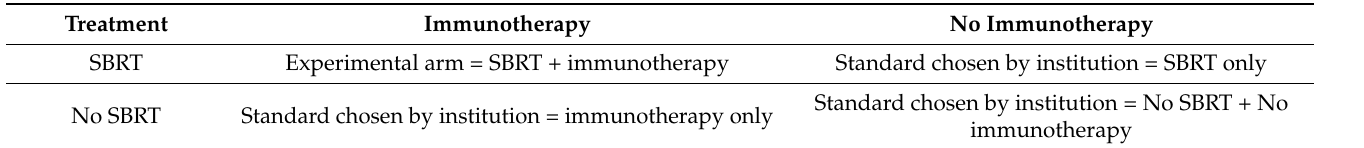
Table 2. Proposed randomized study to test the hypothesis that stereotactic body radiotherapy and immunotherapy may improve survival of older patients with